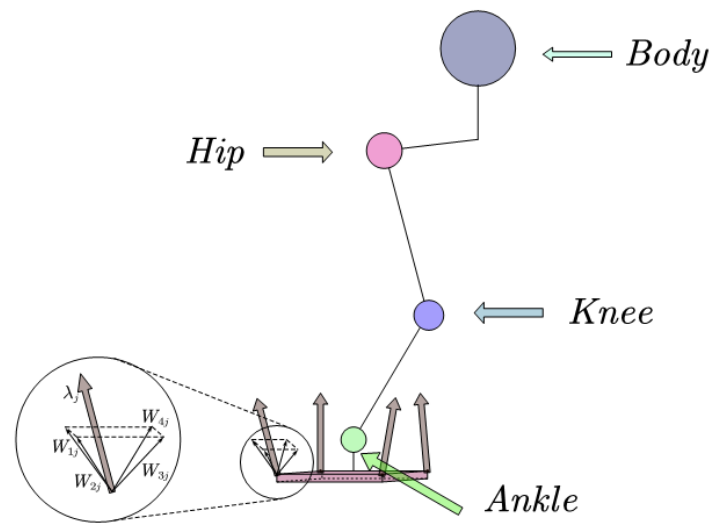
Figure 1. The simplified plantar of the robot.